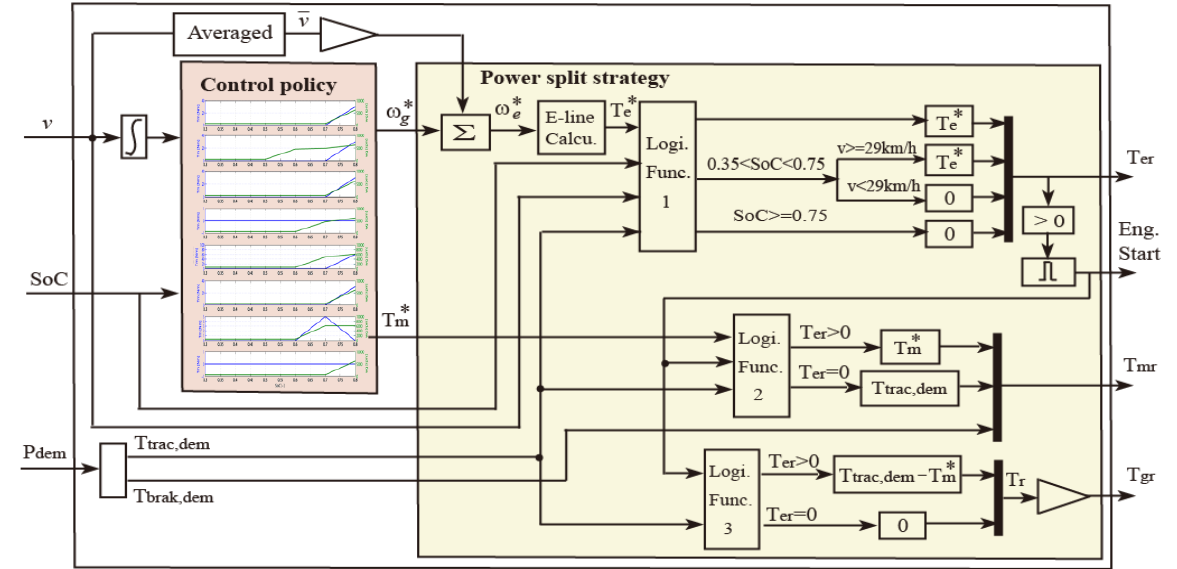
Figure 13. Schematic diagram of the torque-split controller in simulation.